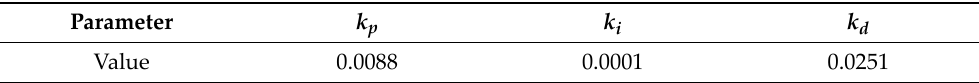
Table 3. Tuned PID parameters.